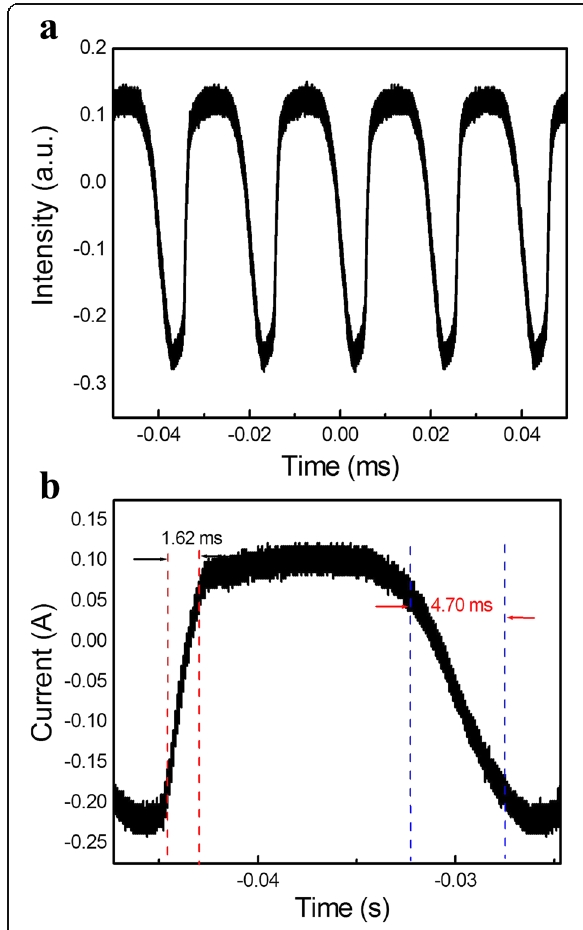
Fig. 9 Current – time properties of single CdSSe NB photodetector upon 674-nm light illumination with 4.87 mW/cm 2 power density under 1 V bias. a I – t characteristics with on/off switching. b The voltage rise and decay edge of a pulse response